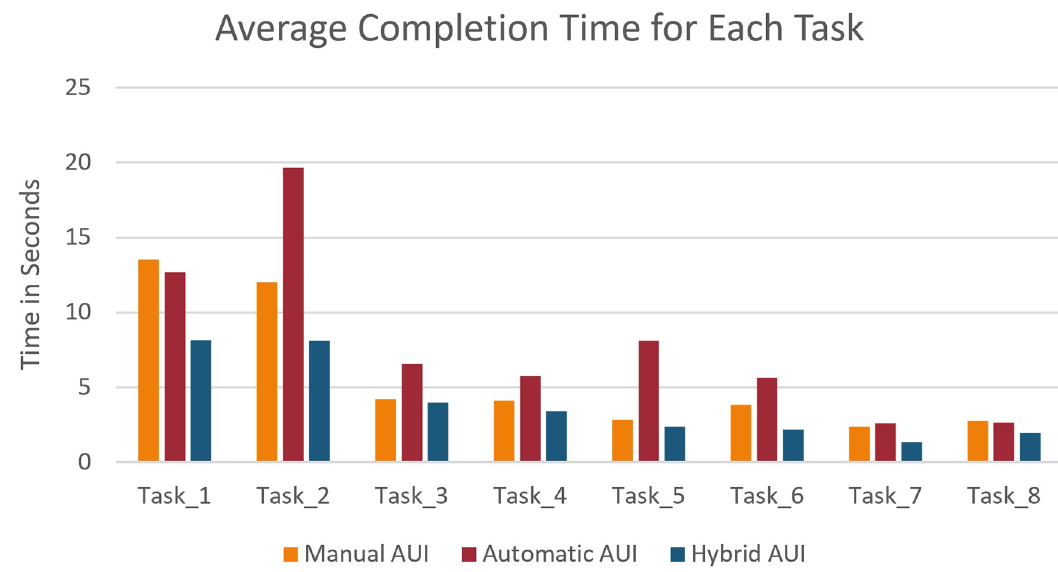
Fig 16. Average completion time for each AUI and each task.